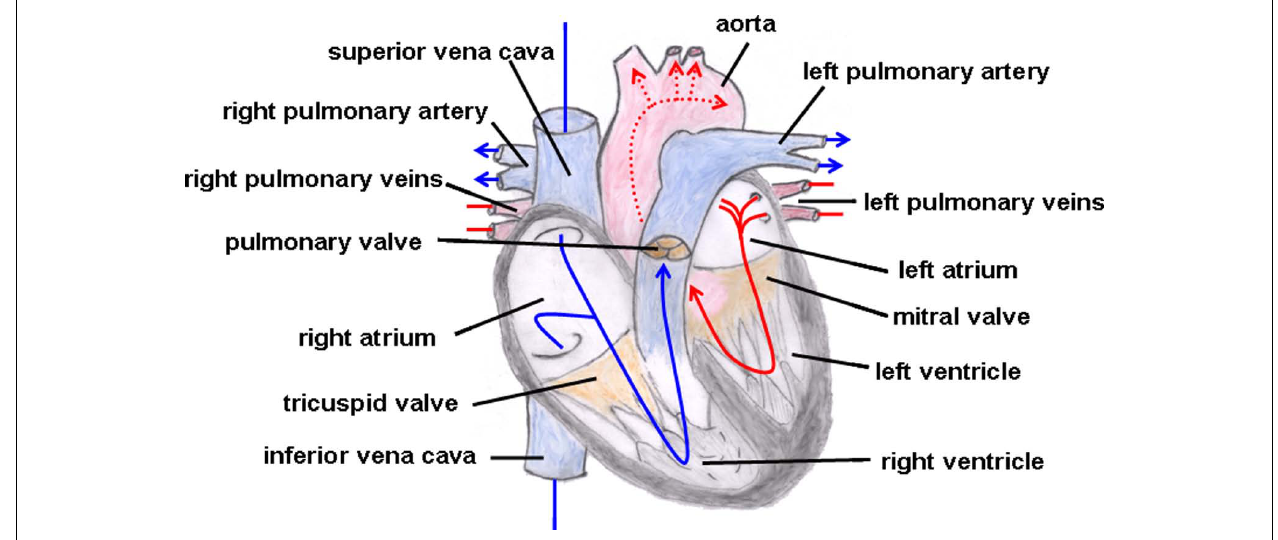
FIGURE 2 | Normal cardiac anatomy. The blue arrows give the flow of oxygen-poor blood from both caval veins via the right atrium and the right ventricle to the left and right pulmonary artery.The red arrows give the flow of oxygen-rich blood from the pulmonary veins via the left atrium and the left ventricle to the aorta.